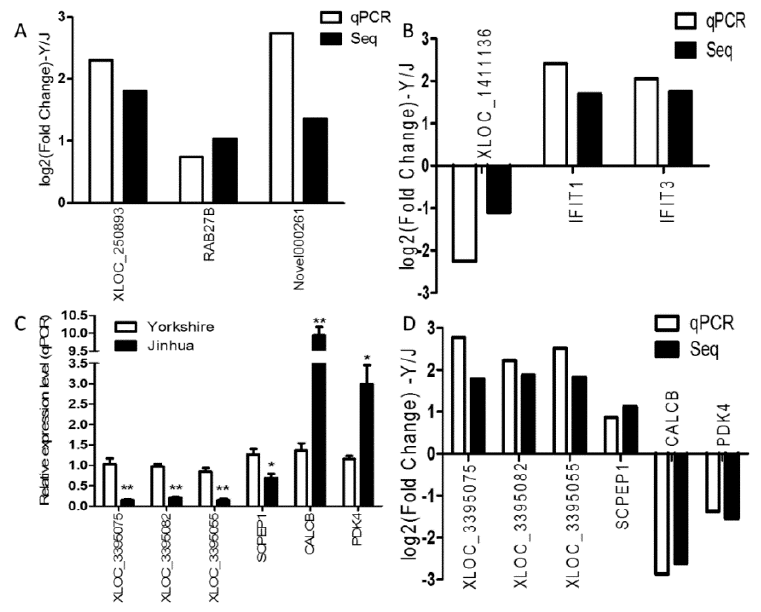
Figure 3. Validation of the RNA ‐ seq data by qRT ‐ PCR. ( A ) The expression patterns of XLOC_250893 and its target genes ( RAB27B and Novel000261 ); and ( B ) for XLOC_1411136 and its target genes ( IFIT1 and IFIT3 ) were verified by qRT ‐ PCR; ( C ) The relative expression levels of six randomly selected genes were expressed as the mean ± SEM. * p < 0.05, ** p < 0.01; ( D ) Fold ‐ change of the Yorkshire pigs versus the Jinhua pigs were verified by qPCR.